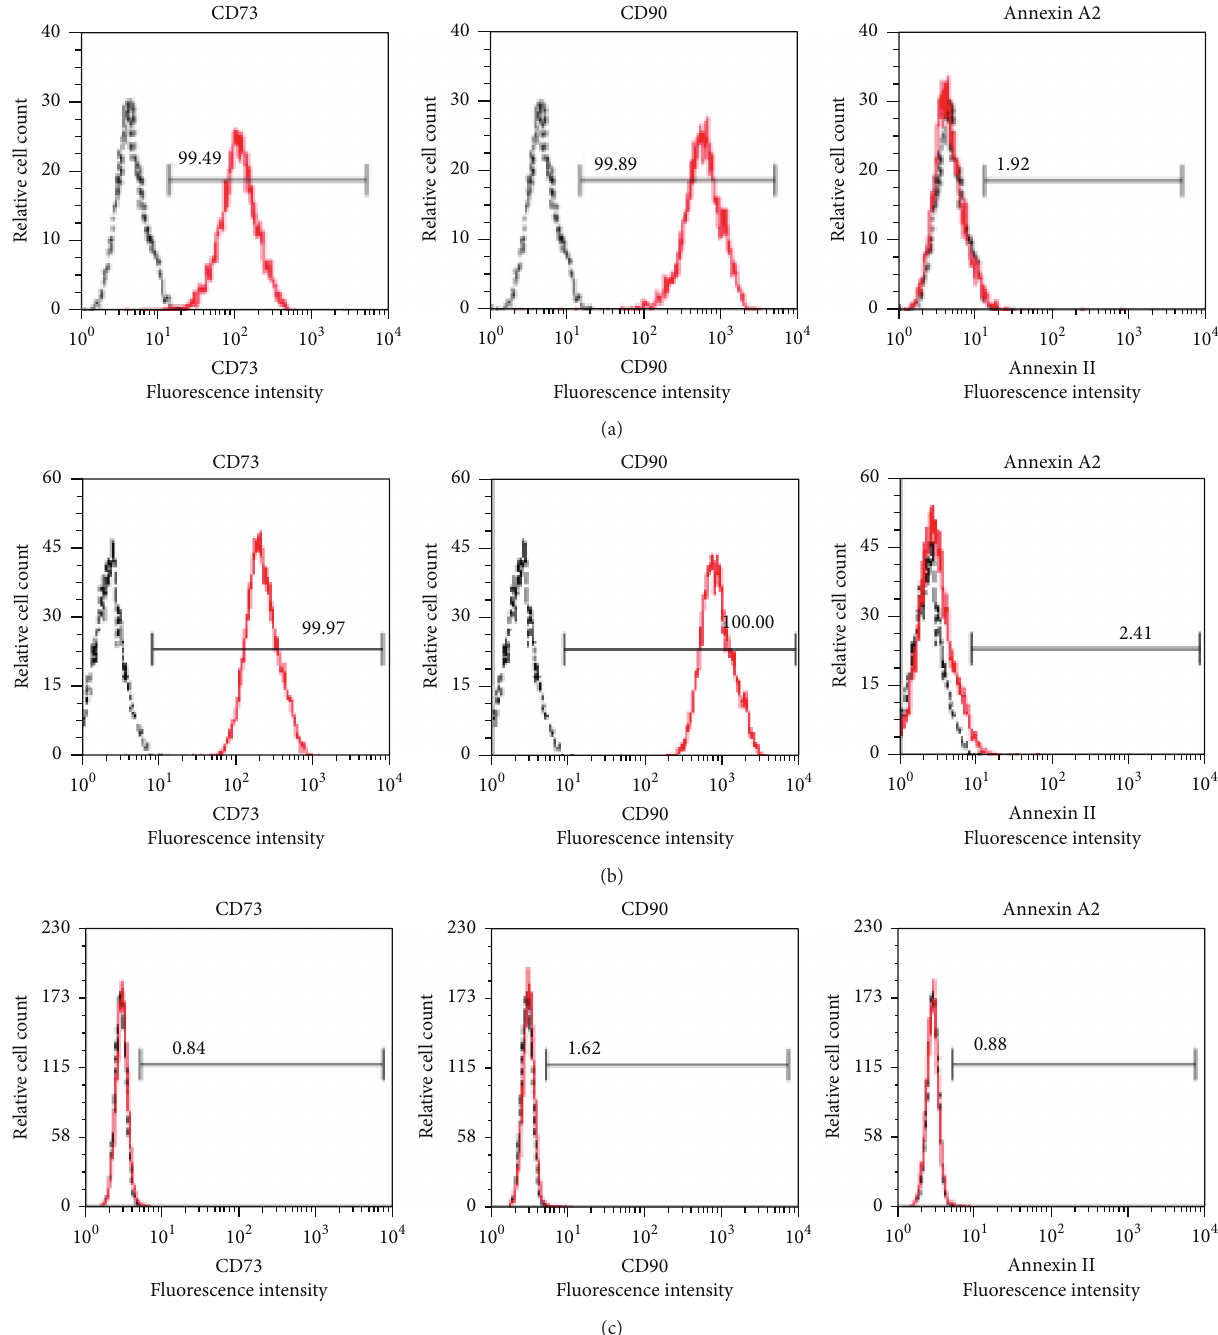
Figure 2: Validation of surface expression of CD73, CD90, and Annexin A2 using flow cytometric analysis in human (a) periodontal ligament stem cells, (b) gingival fibroblasts, and (c) skin